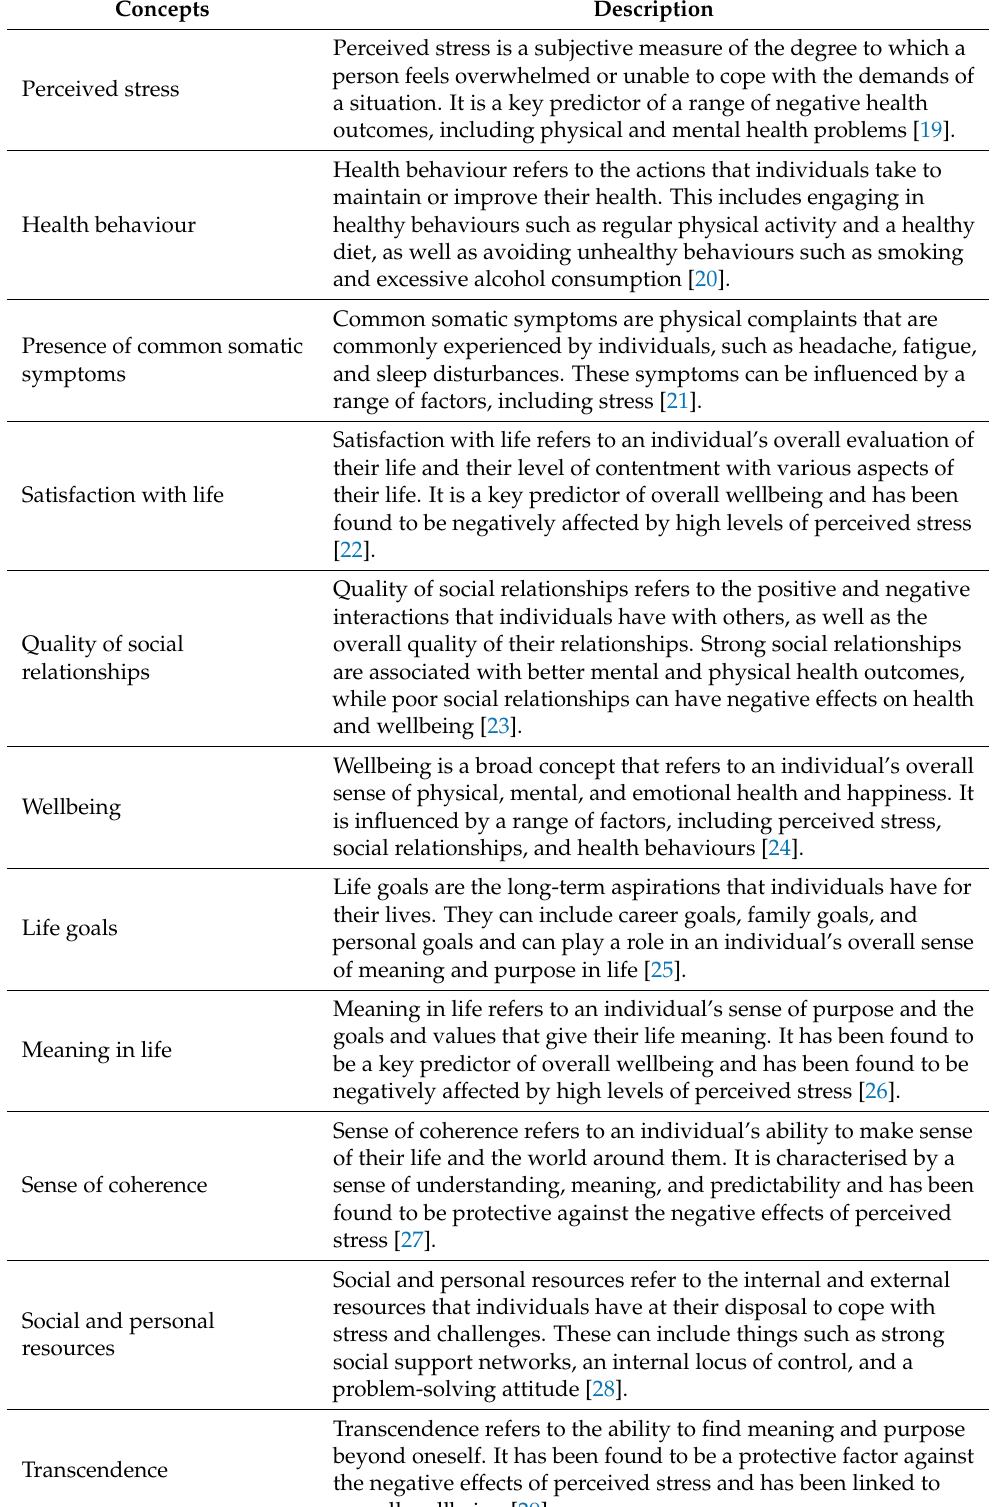
Table 1. Concepts we planned to use in this study and their